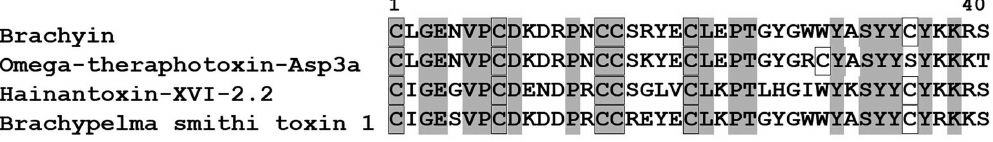
Figure 3. Sequence alignment of precursors encoding spider venom neurotoxin peptides. Identical amino acid residue are in shade. Cysteines that may form disulfide bonds are boxed.